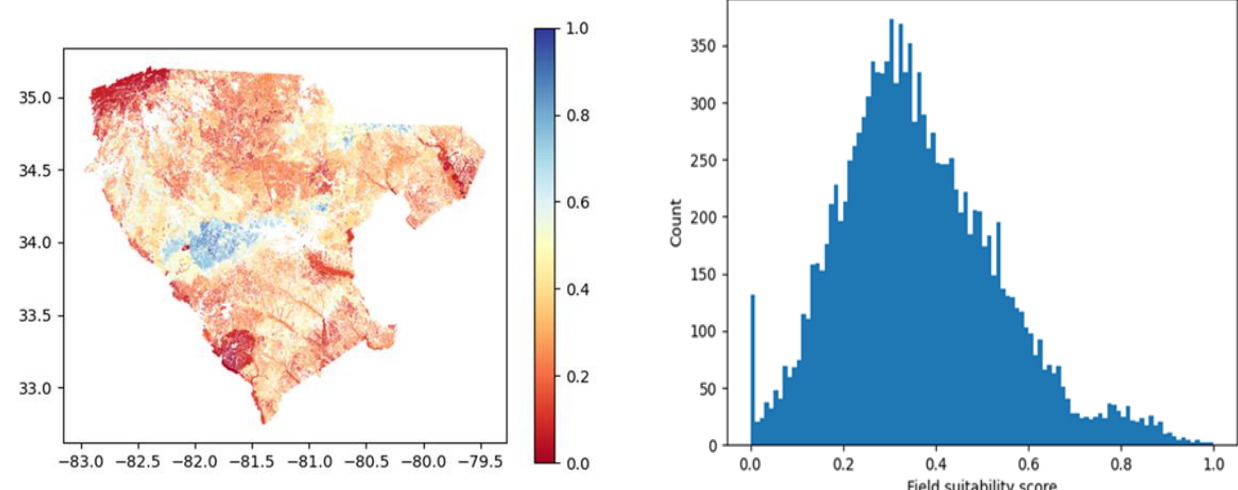
Figure 6. Map of fields ( left ) with suitability score for woody crops, where low-scoring fields are in the red spectrum and high-scoring fields in the blue spectrum. The histogram ( right ) shows the SSI distribution for all fields in the region.